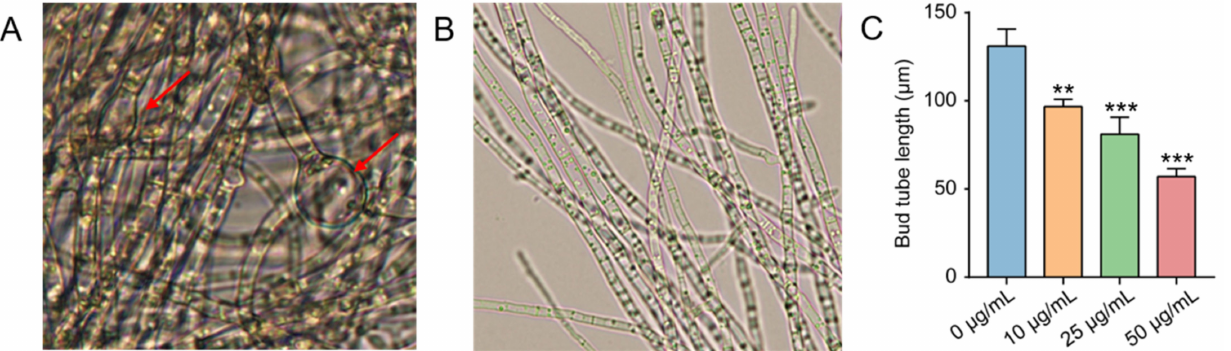
Figure 5. Effects of compound 4 on germ tube elongation and morphology of A. solani. ( A ) Mycelial morphology after compound 4 treatment (24 h). ( B ) Morphology of normal hyphae. ( C ) Length of germ tube treated with different concentrations of compound 4 (24 h). ** indicates a significant difference ( p < 0.01) and *** indicates a significant difference ( p <